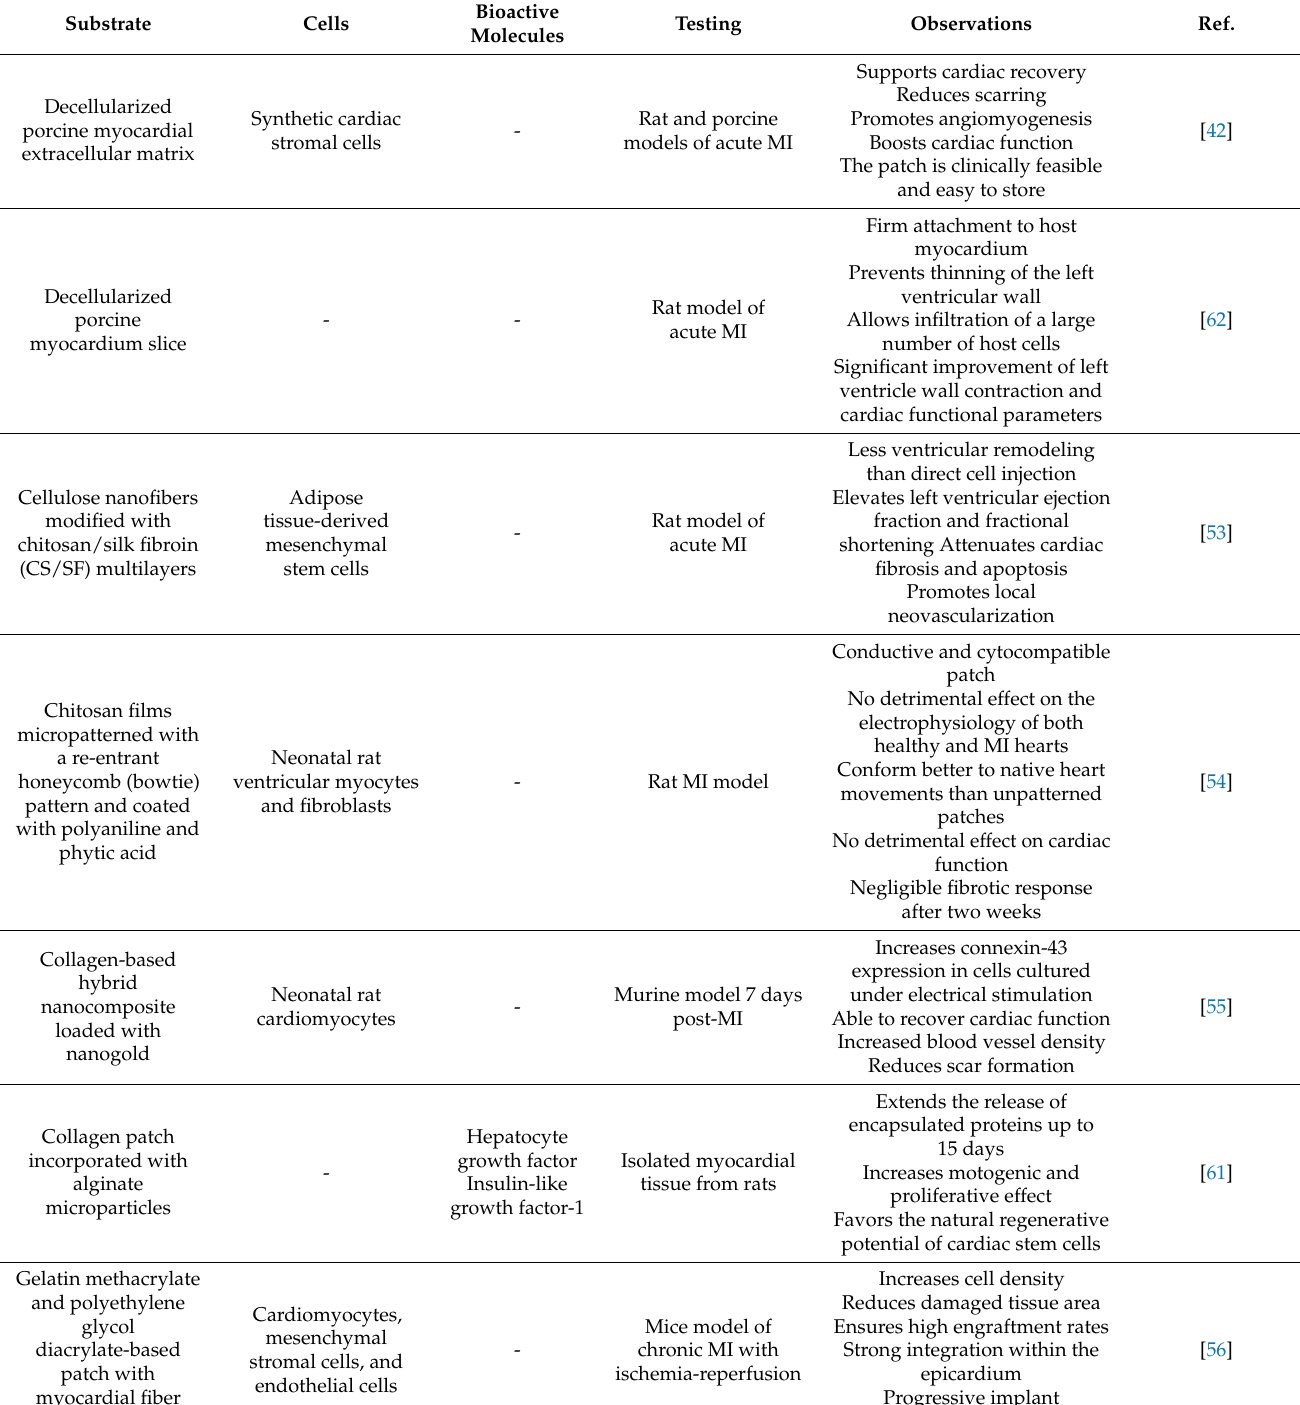
Table 1. Examples of recently developed cardiac